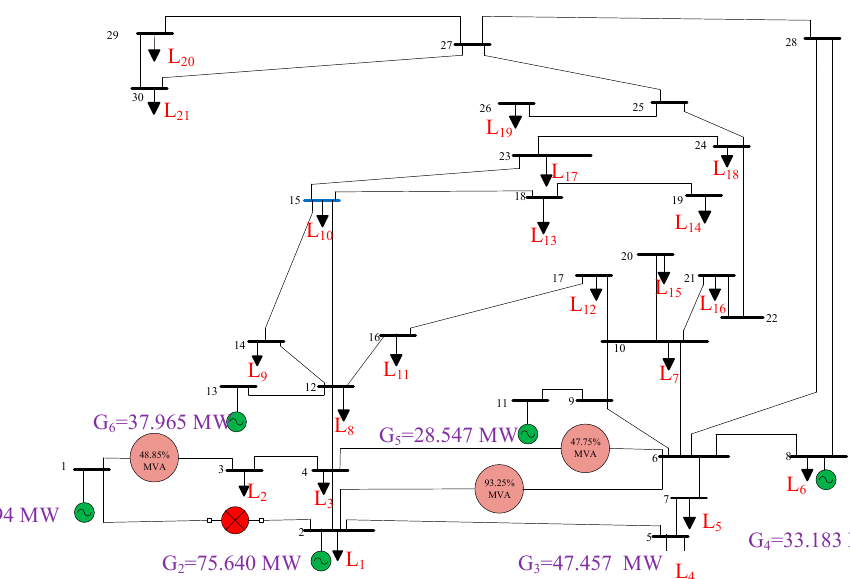
Figure 8. Mitigation of congestion employing Flower Pollination Algorithm.